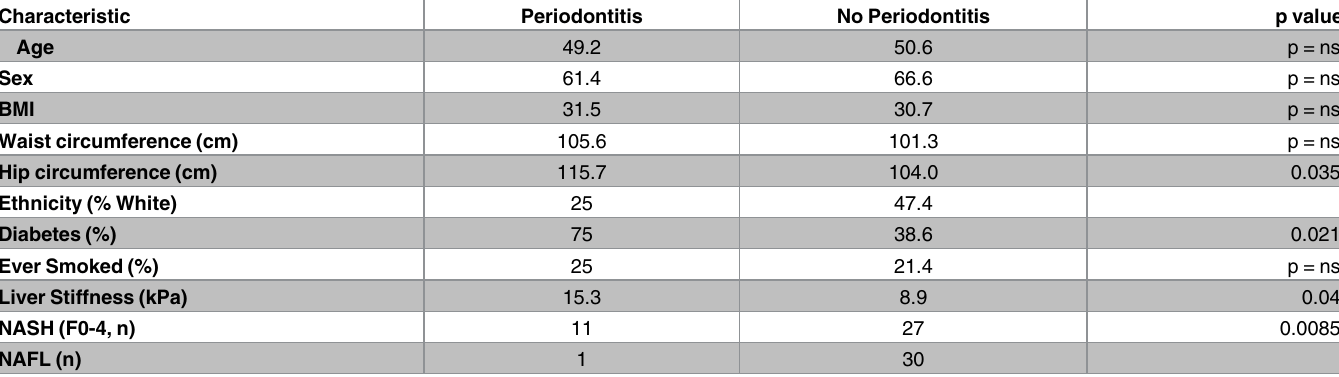
Table 4. Characteristics of patients recruited in prospective (London) cohort with periodontitis or no periodontitis.